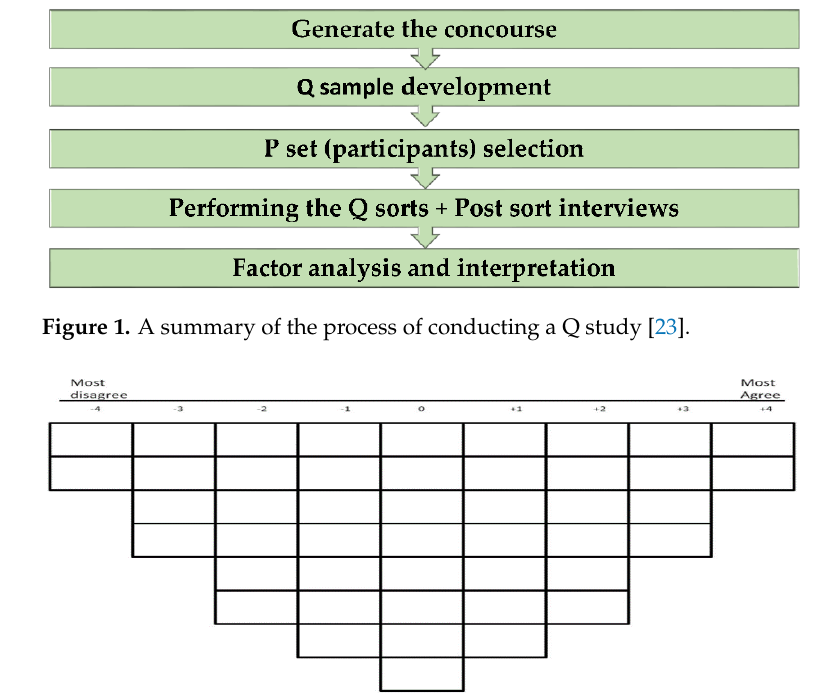
Figure 2. Grid for Q studies .